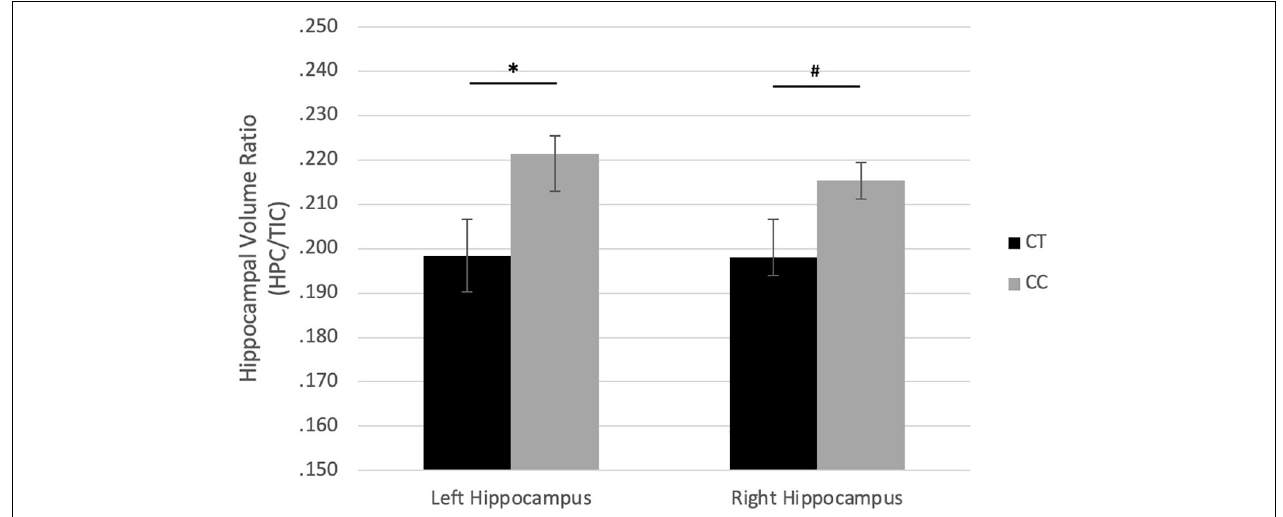
FIGURE 2 | Effect of rs6265 (BDNF) genotype on hippocampus/TIC ratio volume in girls. # p < 0.10, ∗ p <